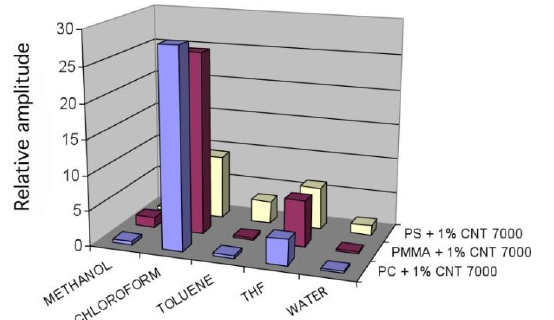
Figure 7. The influence of both the polymer matrix (poly(styrene) (PS), poly(methyl methacrylate) (PMMA) and poly(carbonate) (PC)) and CNT treatment on the sensors’ chemoresistive responses when conductive polymer nanocomposite (CPC) are filled with ( left ) neat 7000 CNT and ( right ) COOH functionalized